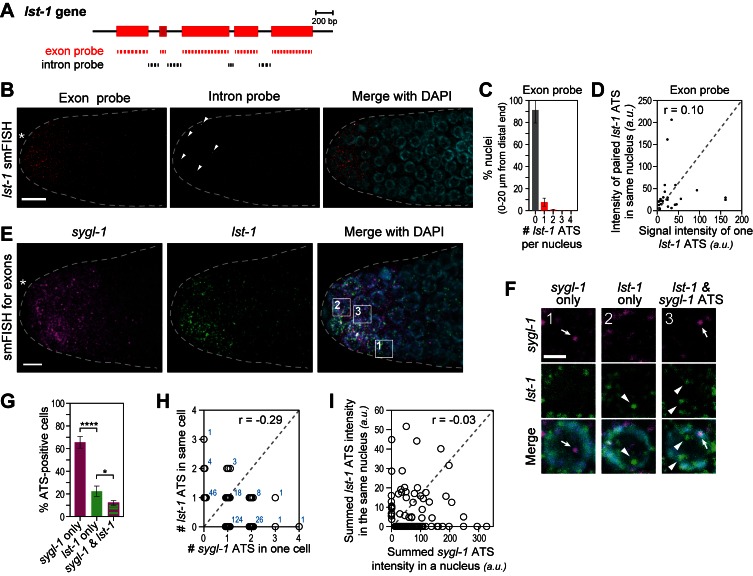
The lst-1 transcriptional response to Notch signaling.(A) Schematic of lst-1 exon/intron structure. Exon-specific (red) and intron-specific (black) smFISH probes were labeled with different fluors (see Materials and methods). (B) lst-1 smFISH in distal gonad. Exon probes (red); intron probes (white). DAPI marks nuclei (blue). Arrowheads indicate ATS. Conventions and scale as in Figure 1E. (C) Percentage of nuclei with 0–4 lst-1 ATS per nucleus, calculated from 2107 nuclei in 36 gonads: 162 nuclei had one ATS, 15 had two ATS, 3 had three ATS and 2 had four ATS. Error bars: standard deviation. (D) Pair-wise comparisons of lst-1 ATS intensities within one nucleus (total of 30 ATS from 36 gonads). Each black dot represents one pairing. Grey dashed line indicates a perfect correlation (Pearson’s correlation coefficient r = 1); r indicates correlation coefficient from data. (E) Double-labeled smFISH against sygl-1 (magenta) and lst-1 (green) exons using distinct fluors (see Materials and methods). Conventions and scale as in Figure 1E. Full Z-projection is shown. (F) 10X magnification of nuclei within boxes in Figure 4E, right panel. Each panel shows a restricted Z-projection that only includes the corresponding nucleus. Arrow: sygl-1 ATS; arrowhead: lst-1 ATS. Scale bar: 2 μm. (G) Percentage of cells with sygl-1 ATS only, lst-1 ATS only or both sygl-1 and lst-1 ATS, out of all ATS-positive cells identified (n = 233 cells from 15 gonads). ****p-value<0.0001 and *p<0.05 by t-test. (H) Plot of nuclei possessing both sygl-1 and lst-1 ATS, with each open circle representing one nucleus (n = 233; 15 gonads). Overlapping data points (open circles) are spread using ‘jitter’ function in MATLAB. Blue numbers show how many nuclei of each type were found. For example, three nuclei had two lst-1 ATS and one sygl-1 ATS. Pearson’s correlation coefficient (r) is shown on top. Grey dashed line indicates a perfect correlation (r = 1). (I) Comparison of summed ATS intensities of sygl-1 and lst-1 within the same nucleus (data from 128 nuclei in 9 gonads). Each open circle represents a nucleus. r indicates Pearson’s correlation coefficient from data. Grey dashed line indicates a perfect correlation (r = 1).